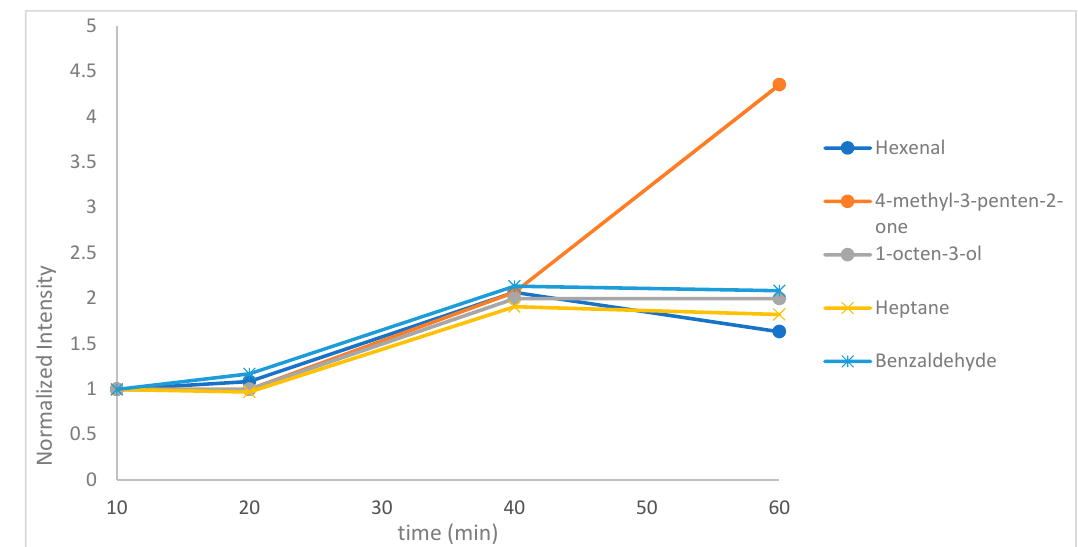
Figure 1. Effect of extraction time on hexanal, 4-methyl-3-penten-2-one, heptane, benzaldehyde and 1-octen-3-ol.